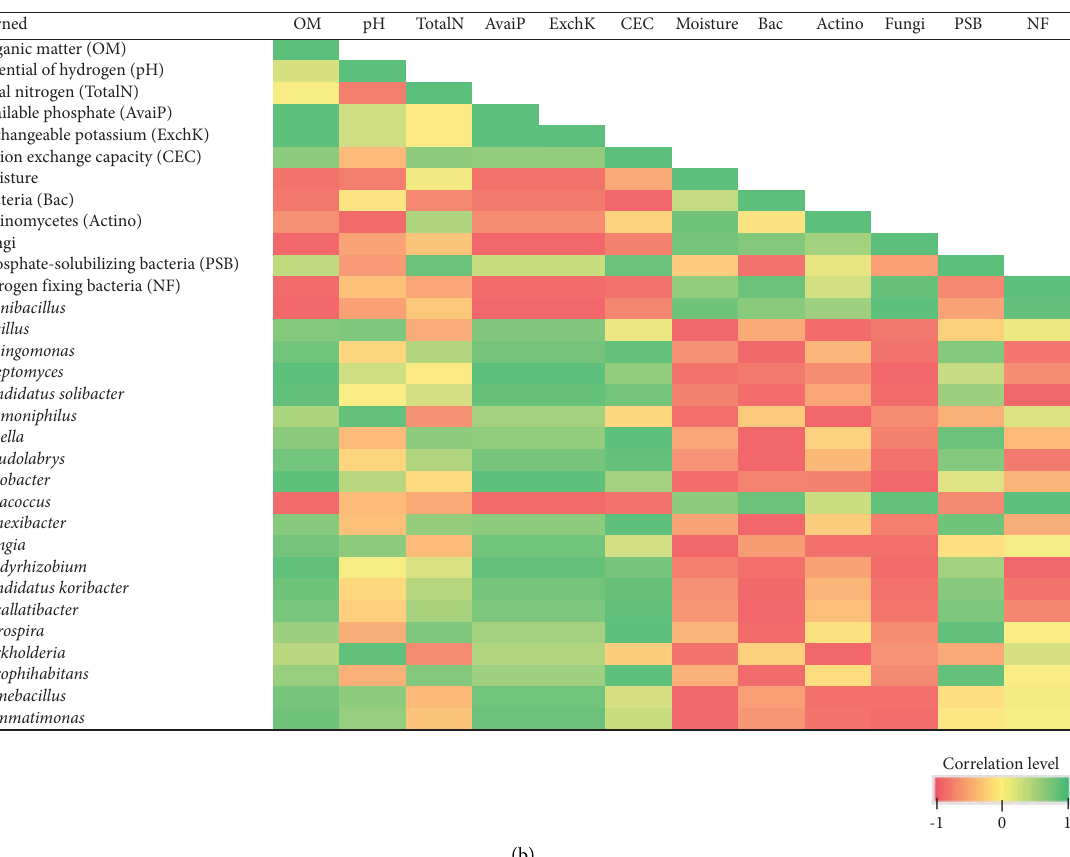
Figure 4: Correlation coefcients of physiochemical properties, microbial count, and bacterial structure of (a) unburned and (b) burned soils. Te heat map correlation levels are colored in green (positive) or red (negative) hues, while no correlations are shown in